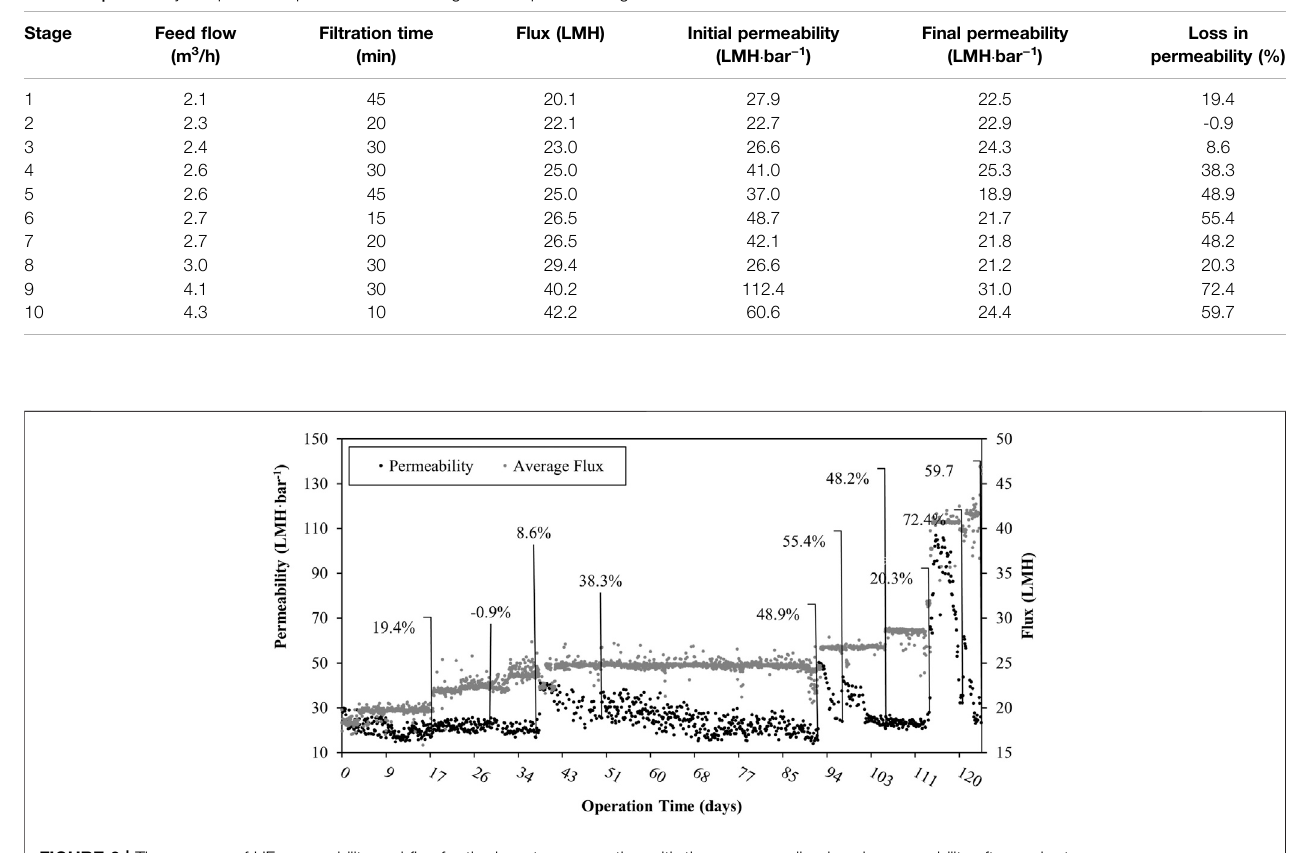
FIGURE 3 | Time-course of UF permeability and fl ux for the long-term operation with the corresponding loss in permeability after each stage.